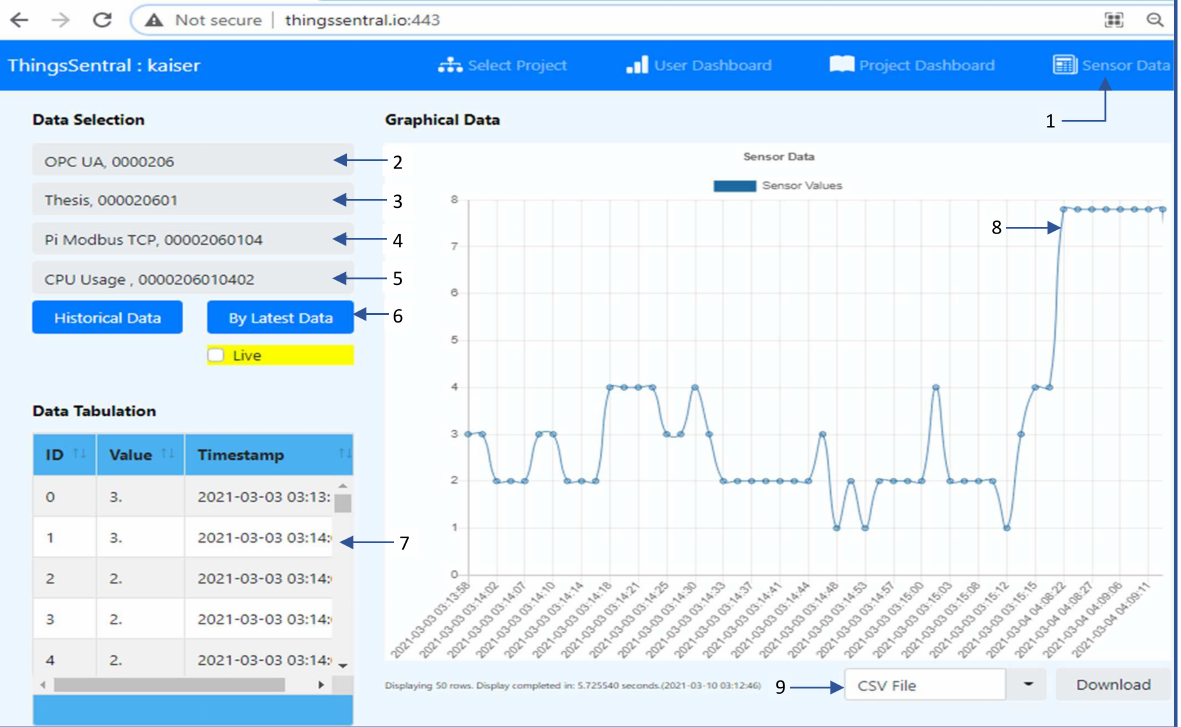
Figure 12. Data monitoring from the “Sensor Data” page of the ThingsSentral TM cloud